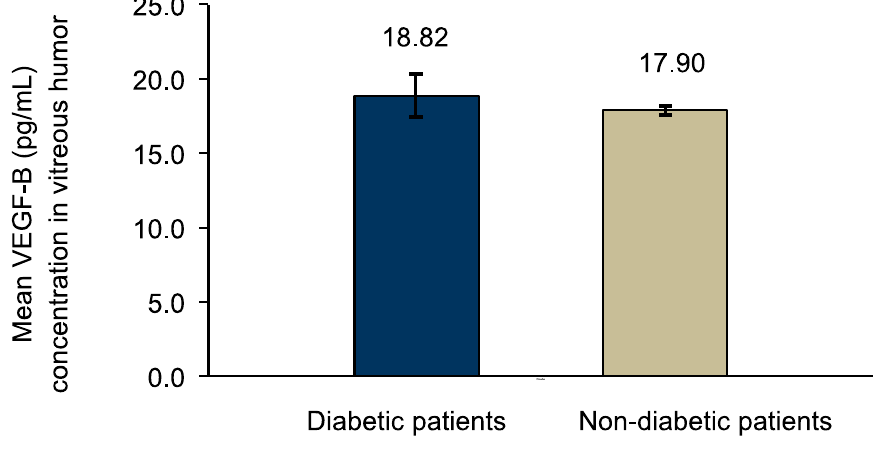
Figure 1. Comparison of VEGF-B vitreous levels between diabetic patients ( n = 25) and non-diabetic patients ( n = 8), analyzed with independent samples, t -test ( p = 0.006). 3.3. Comparison of Vascular Endothelial Growth Factor B Levels in Vitreous Humor between Patients with Proliferative Diabetic Retinopathy vs. Non-Proliferative Diabetic Retinopathy Mean VEGF-B measurements were higher in vitreous humor of patients with PDR (19.03 ± 1.52 pg/mL) vs. NPDR (18.18 ± 0.96 pg/mL), and this difference was statistically significant ( p = 0.025) (Figure